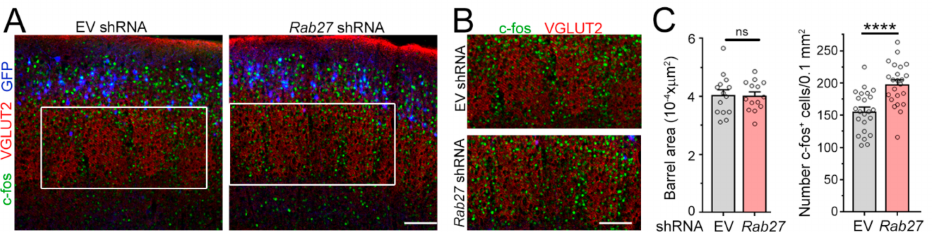
Figure 3. Decreasing Rab27a in L2/3 neurons leads to an increase in the number of L4 neurons activated by Whisker stimulation. ( A ) Images of c-fos (green), vesicular glutamate transporter 2 (VGLUT2) (red), and GFP (pseudo-colored blue) in slices from mice electroporated with EV or Rab27a shRNA in L2/3 neurons. ( B ) Zoom of c-fos and VGLUT2 images in the white rectangle in ( A ). ( C ) Bar graph of the cross-sectional area of barrels and the density of c-fos + cells under both conditions (n = 4 mice with EV and n = 5 mice with Rab27a shRNA, n = 23 slices in each condition). The barrels were delineated using VGLUT2 immunostaining. Unpaired t-test. Plots are mean ± SEM including data points. ****: p < 0.0001 and ns: not significant. Scale bars: 100 µ m ( A ) and 80 µ m ( B